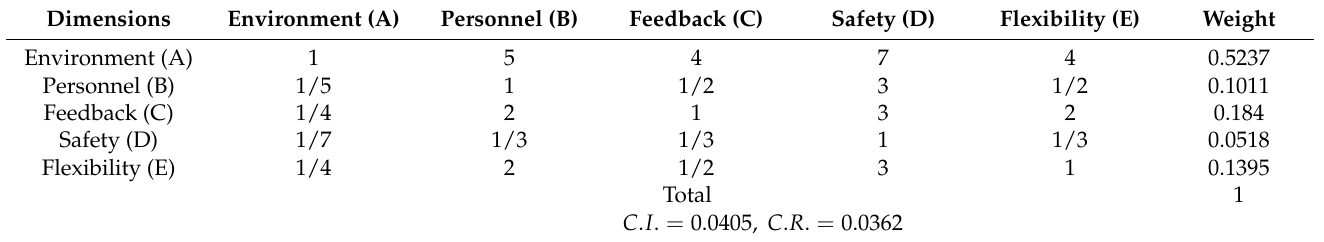
Table 9. The pairwise comparison matrix for five main criteria from FANP model.